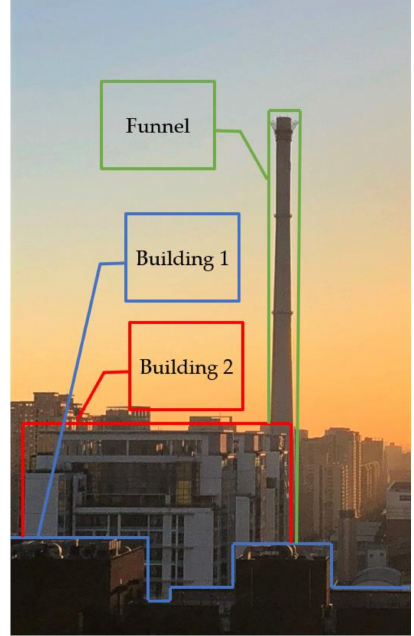
Figure 8. Marked image.